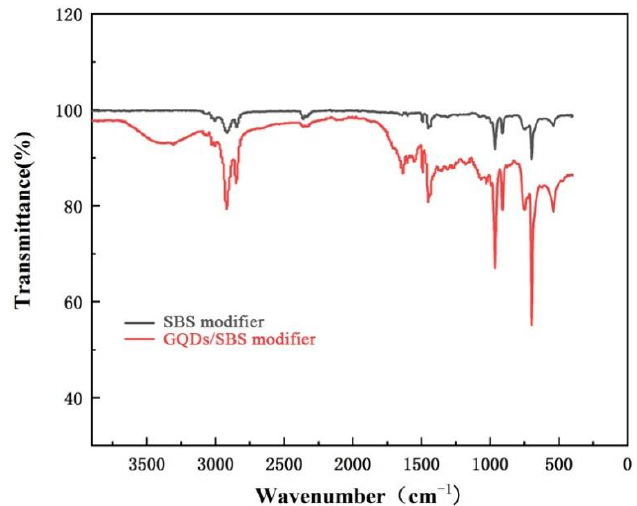
Figure 4. FTIR spectrum of GQDs/SBS composite modifier and SBS modifier.